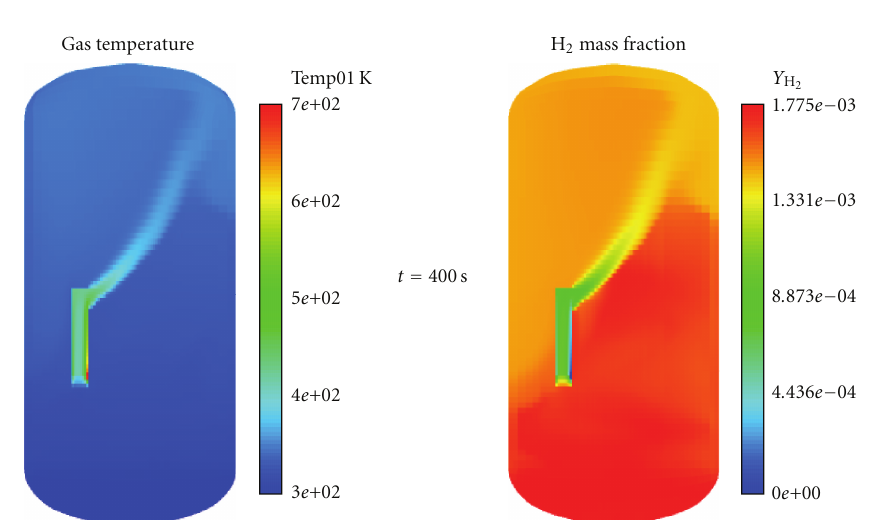
Figure 15: Gas temperature and hydrogen mass fraction